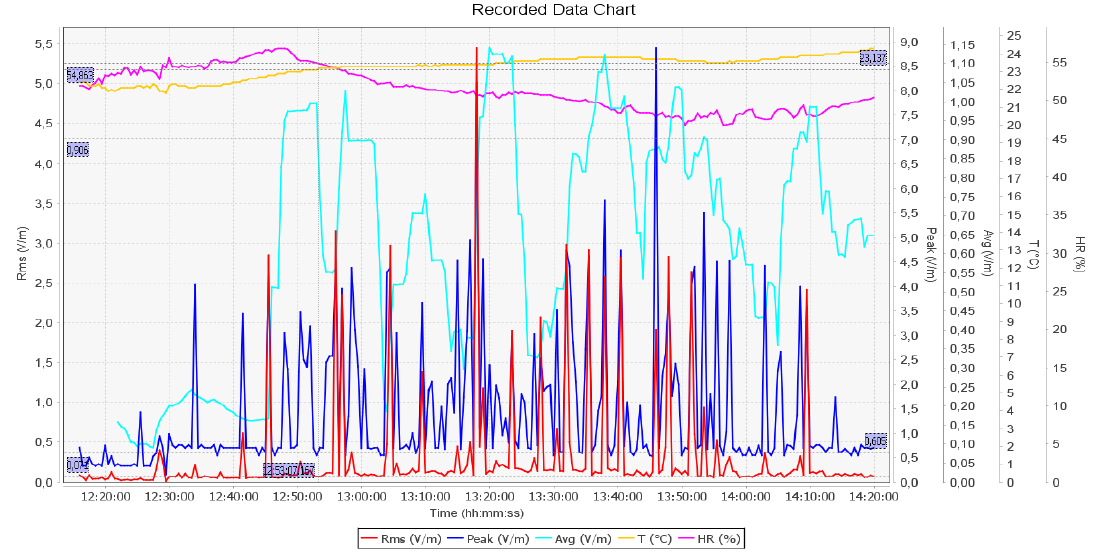
Figure 6. The intensity of the electrical component of the electromagnetic field in the course of flight no. 1 for the Cessna 172.